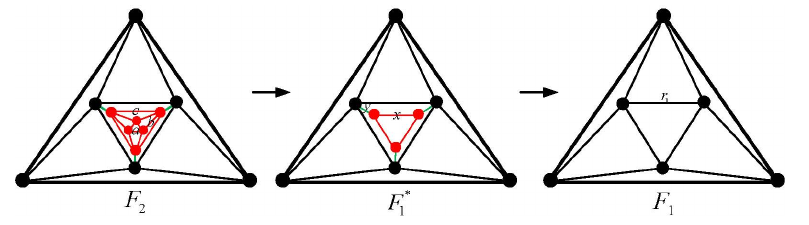
Fig. 6. The transformations from F 2 to F 1